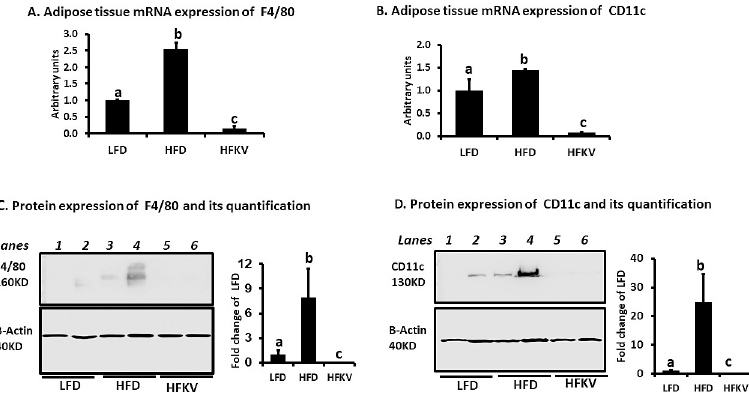
Fig 5. Supplementation with kale reduced adipose tissue markers of inflammation. Quantitative PCR and western blotting showed that: (A). The HFD increased gene expression of F4/80 compared to LFD (P < 0.05). The HFKV diet decreased expression of F4/80 to levels below those of both the HFD diet and LFD groups (P < 0.05). (B). The HFD diet increased gene expression of CD11c compared to LFD diet (P < 0.05). The HFKV diet attenuated the increase in CD11c to levels below those of both the HFD and LFD groups (P < 0.05). (C). The HFD diet increased the protein expression of F4/80 compared to LFD. The HFKV diet decreased F4/80 to levels not detectable by western blotting (P < 0.05). Bar chart represents quantification of the gel blot in Image-J. (D). The HFD diet increased the expression of CD11c compared to LFD. The HFKV diet decreased expression of CD11c to levels not detectable by western blotting (P < 0.05). The bar chart represents quantification of the gel blot in Image-J. The test proteins and β -actin were determined on the same membranes but at different exposure times. Full membranes are shown in S1 Fig. ‘a’ Different letters indicate significant differences after ANOVA at P <